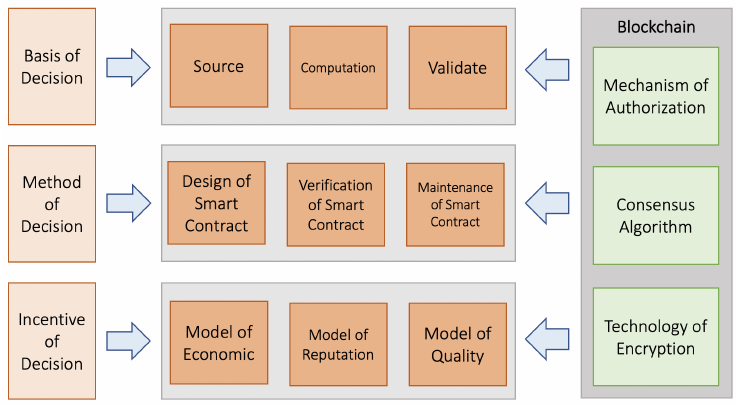
Figure 2. Cryptocurrency management framework.